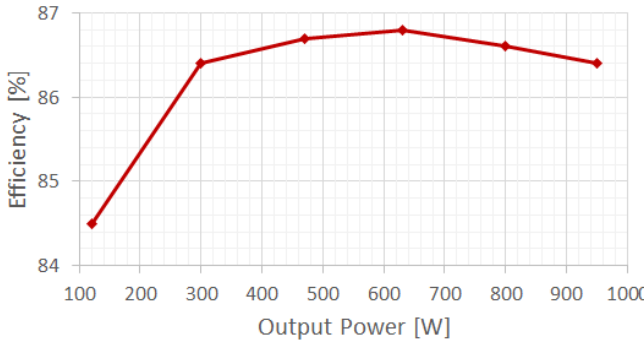
Figure 11. The efficiency of the proposed inverter at the unbalanced condition input voltage, V dc 1 = 20 V and V dc 2 = 25 V.